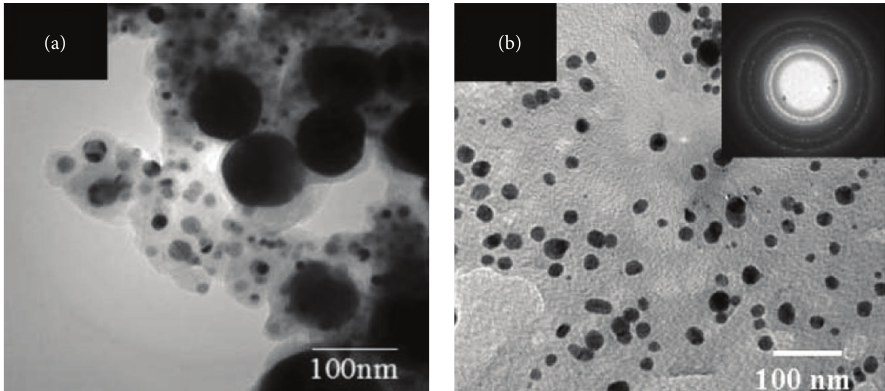
Figure 1: Ag NPs from coffee (a) and tea (b) extract [42]. Copyright license number: 3482980509111.